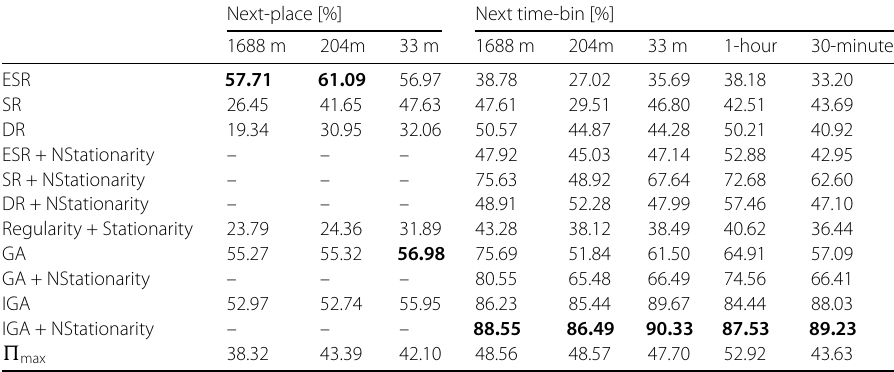
Table 8 An average proportion of accuracy variation explained by the regression models fit to the evaluated metrics presented for the two types of mobility sequences of varied spatio-temporal resolutions Next-place [%] Next time-bin [%] 1688 m 204m 33 m 1688 m